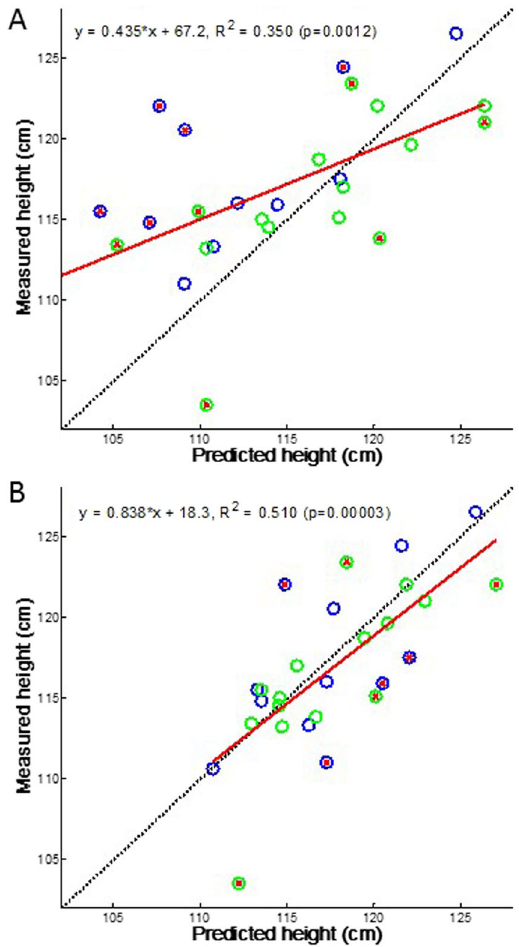
Figure 6. Prediction of measured height in the subset of 27 subjects who had complete data set between birth and 12 months of age. ( A ) Prediction of height at 72 months of age with the time-varying biased random walk model using 500 realizations and utilizing height only at 1 month. ( B ) Adaptive prediction of height at 72 months of age with the time-varying biased random walk model using 500 realizations as well as utilizing the growth history including height values at 1, 2, 4, 6 and 12 months of age in the same 27 subjects. Note that the adaptive Bayesian approach significantly improves the overall long term predictability of the target height by including a history of previous observation. Dotted line: line of identity; red line: regression line; blue circles: boys’ height; green circle: girls’ height; red cross in circles: those subjects whose measured height was outside the mean ± SD of the